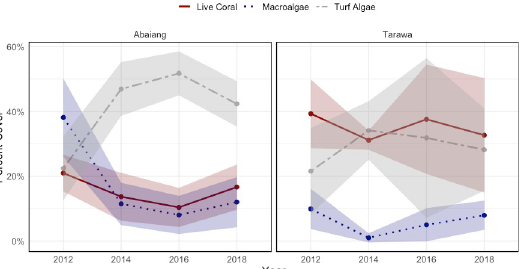
Fig 3. Time series of mean percent cover of live coral, macroalgae, and turf algae by atoll. The shaded area around each line represents the standard deviation of the percent cover. The live coral excludes TRW013 or TRW014, which we did not visit in 2012.